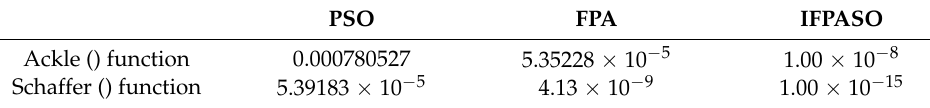
Figure 2. Convergence result ( a ) Ackle() function ( b ) Schaffer() function. Table 1. Comparison results of the three algorithms. PSO Ackle () function